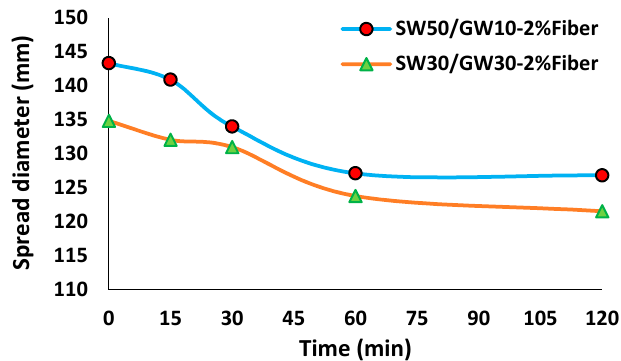
Figure 5. Slump diameter of the fiber-reinforced un-foamed mortars.